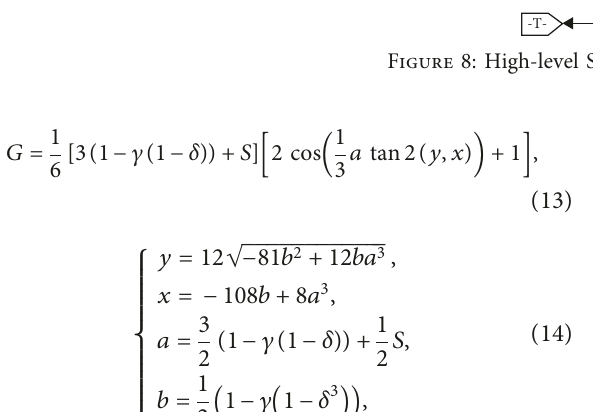
Figure 8: High-level Simscape model